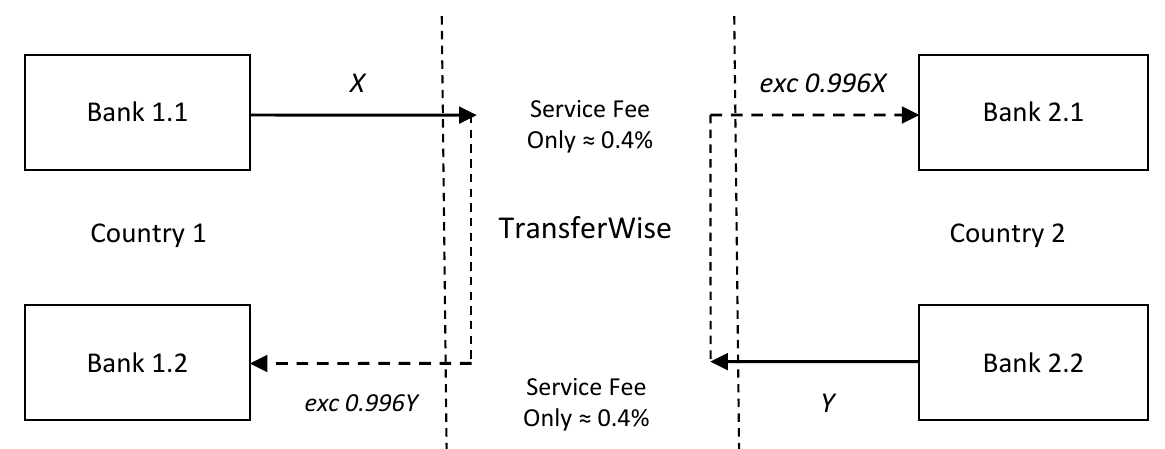
Figure 5. P2P cross-border money transfers with